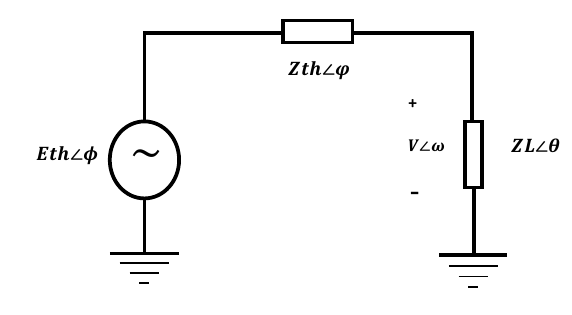
Figure 1. Thevenin equivalent representation of a power system from the load